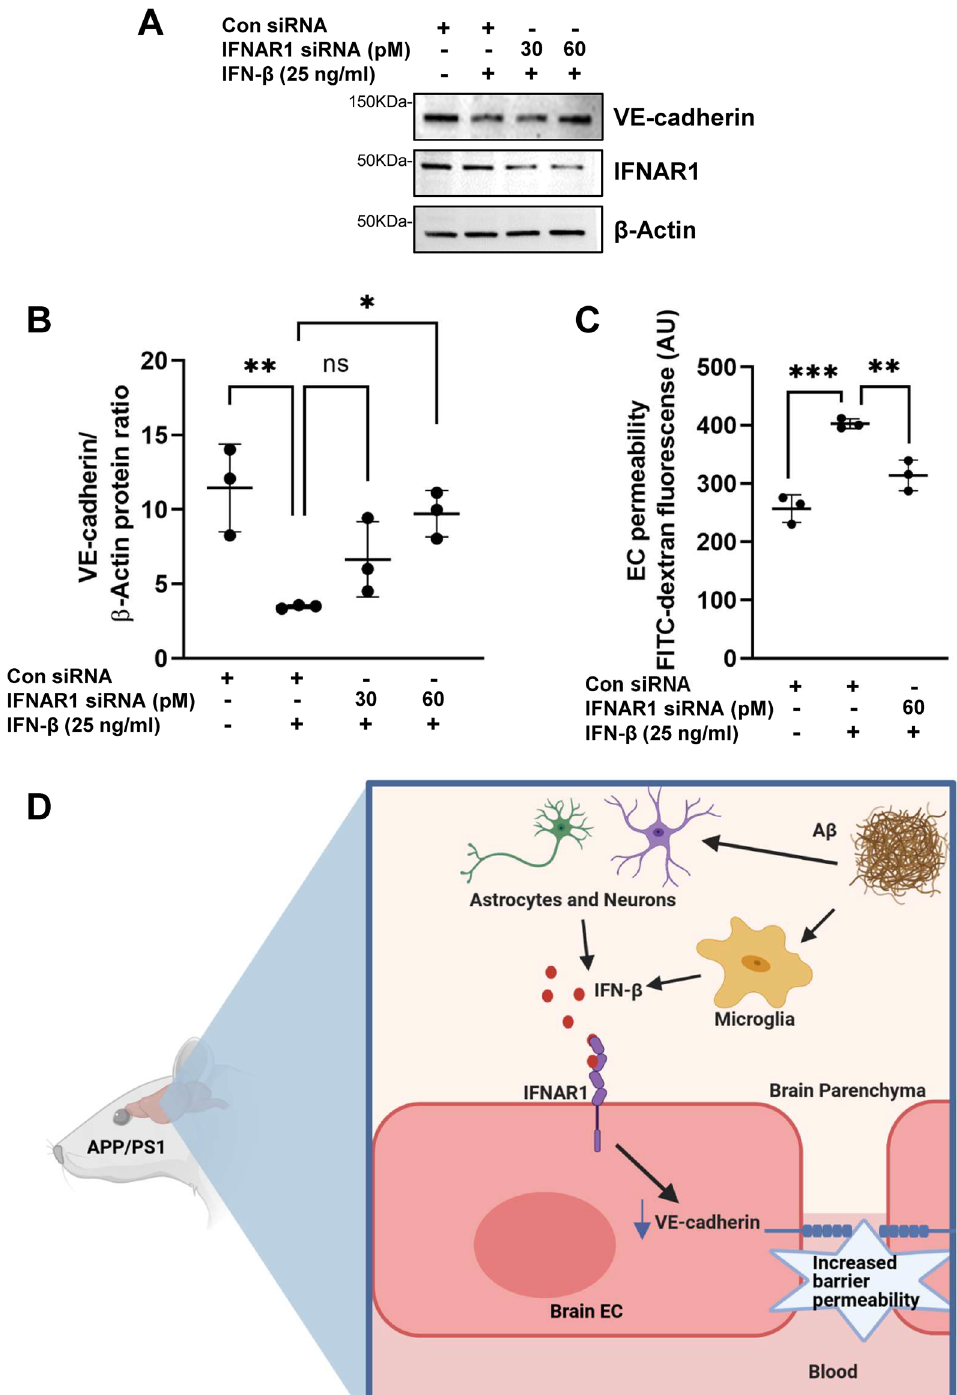
Figure 7. IFN-β induced leakiness in the brain endothelial barrier is mediated via the receptor IFNAR1. ( A ) hCMEC/D3 cells were treated with IFNAR1 siRNA for 48 h and then stimulated with IFN-β for an additional 24 h. IFN-β induced VE-cadherin downregulation was abrogated after transient knockdown of IFNAR1 implicating the involvement of IFN-β signaling through IFNAR1 receptor. β-actin is used as a loading control. Original blot is presented in Supplementary Fig. S8. ( B ). VE-cadherin levels are quantified by image J software. ( C ) IFNAR1 siRNA treatment significantly reversed the IFN-β induced increase of endothelial permeability. Data analyzed by one-way ANOVA followed by Tukey’s multiple comparisons test. * p = 0.0263, ** p = 0.0068; ** p = 0.0049, *** p = 0.0003 respectively. N = 3 independent experiments. ( D ) Schematic representation of possible mechanisms regulating blood brain barrier breakdown in AD. Aβ-induced release of IFN-β from microglia, astrocytes, endothelial cells and neurons disrupts the BBB integrity via IFNAR1 expressed in brain endothelial